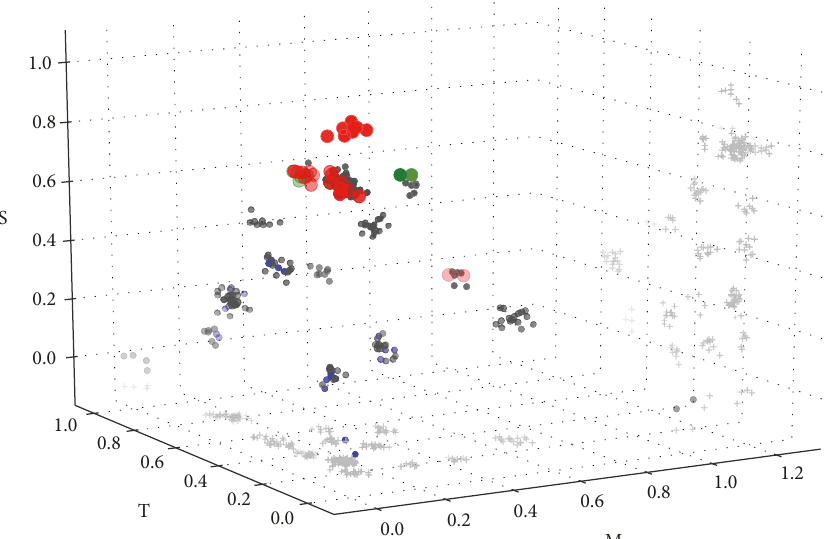
󳨀→ 𝑡=1 Φ (𝑟) for each ECA rule 𝑟 ∈ 0⋅⋅⋅255 , namely, 𝐼 (𝑋 𝑡=1 : 𝑋 𝑡=0 ) (“memory”), 𝐼 (𝑋 𝑡=1 : 𝑋 𝑡=0 ) + 𝐼(𝑋 𝑡=1 : 𝑟 𝑟 𝑖 𝑖 𝑖 𝑖 𝑖−1 𝑖 (𝑋 𝑡=1 : 𝑋 𝑡=0 , 𝑋 𝑡=0 , 𝑋 𝑡=0 )−∑ 𝐼 (𝑋 𝑡=1 : 𝑋 𝑡=0 ) (“synergy”). Each dot corresponds to a rule 𝑟 and is color-coded 𝑟 𝑟 𝛿∈{−1,0,+1} 𝑖 𝑖−1 𝑖 𝑖+1 𝑖 𝑖+𝛿